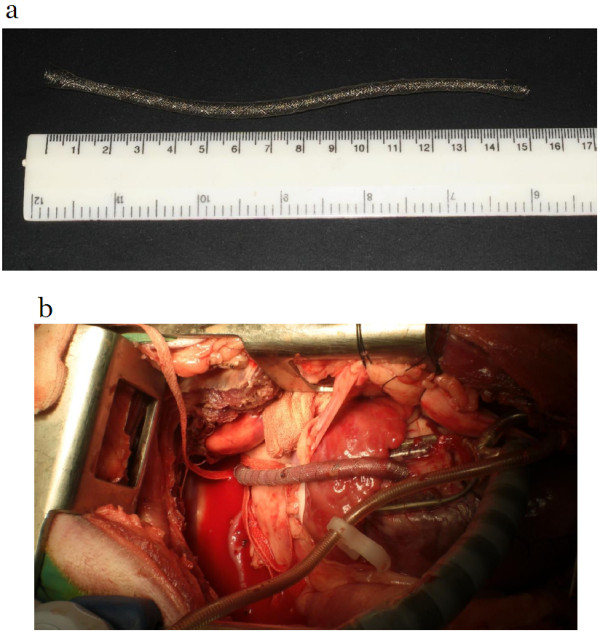
The stretched external support device. a: External support device in its stretched configuration; b: The device treaded open on the vein graft after the second anastomosis.